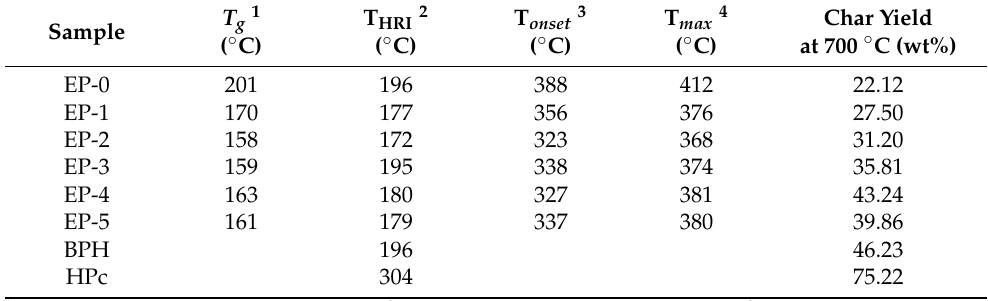
Table 2. Thermal properties of epoxy